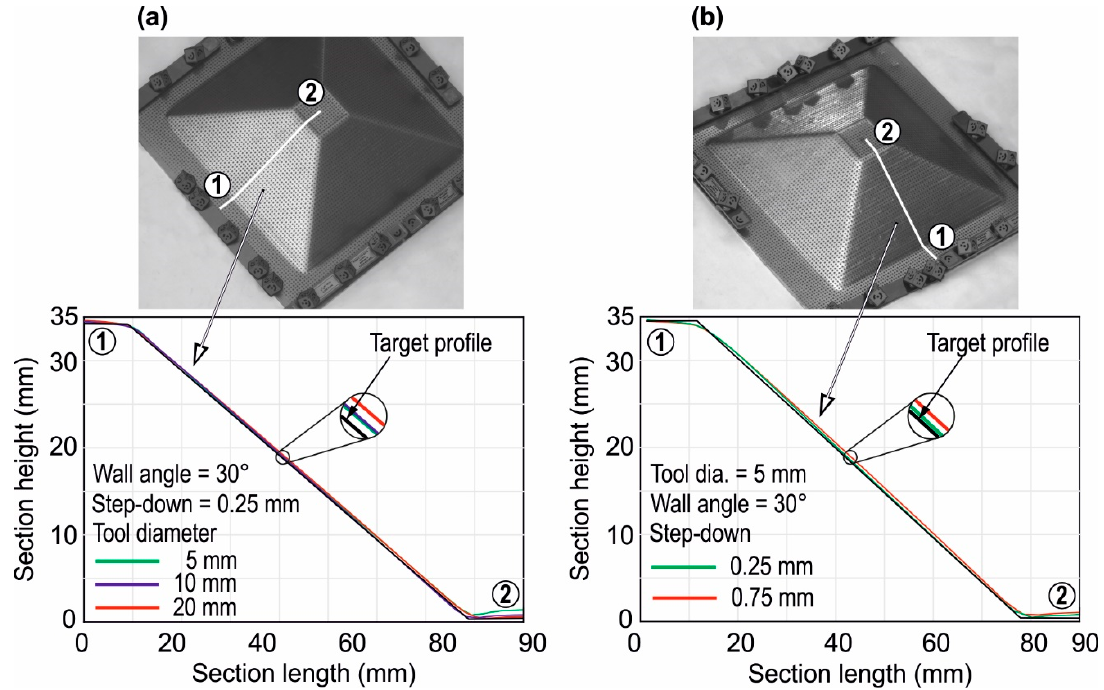
Figure 15. Comparison of the geometric profile with the target geometry for ( a ) different tool diameters and ( b ) different tool step-down values.